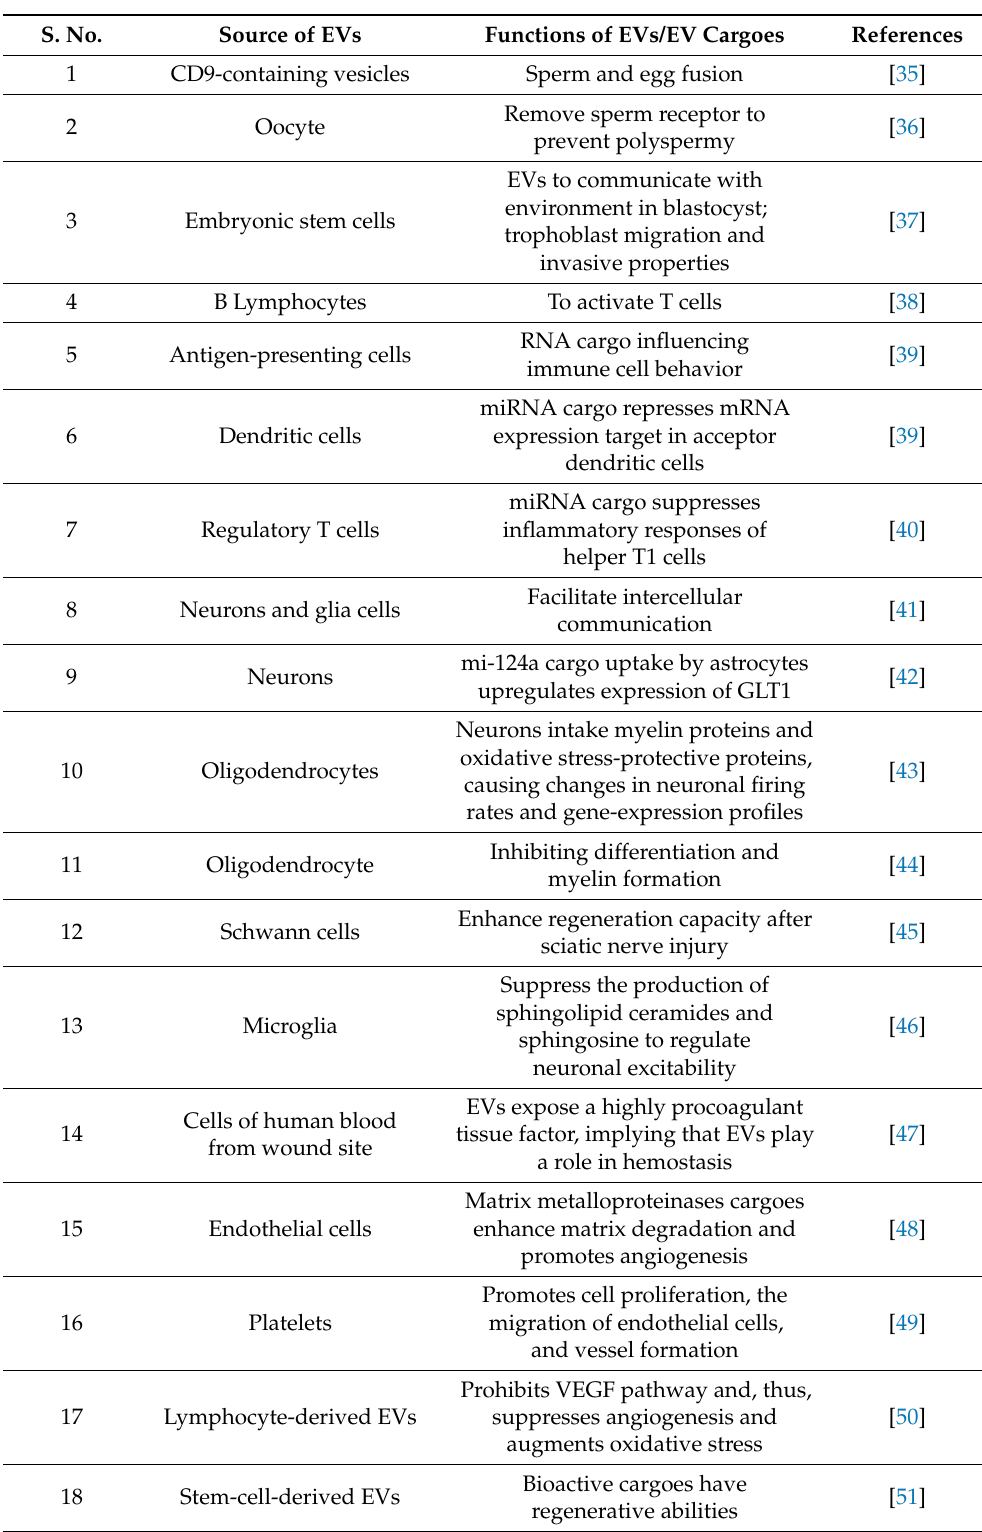
Table 1. List of source and functions of EVs (cargoes) released from normal cells. S.